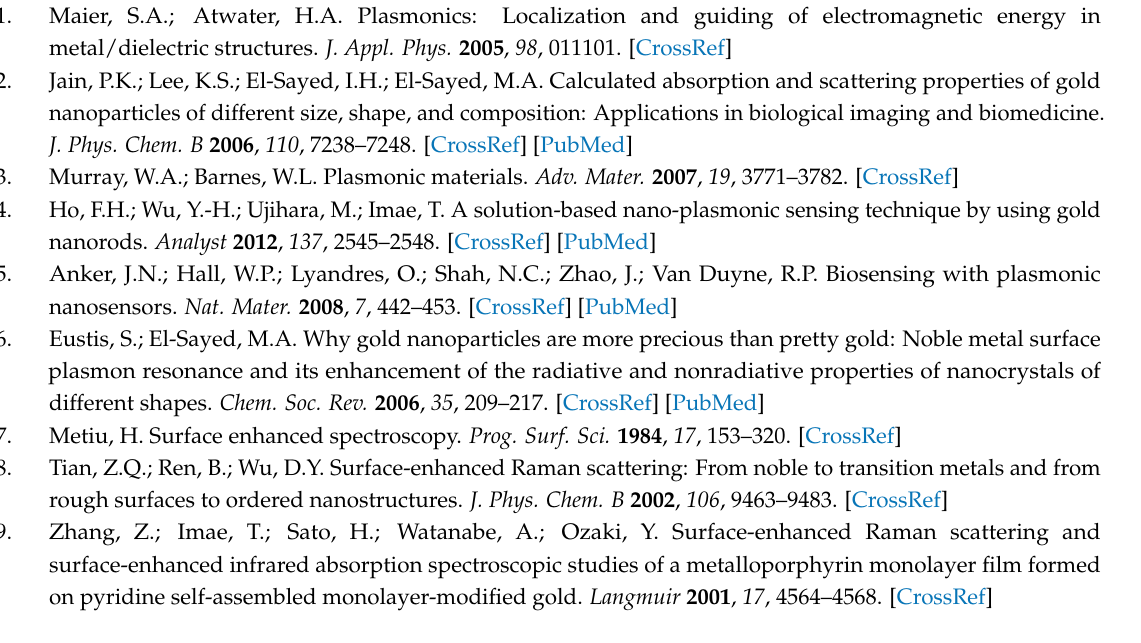
Figure S1: Raman scattering of confeito-like AuNPs without R6G. Figure S2: Raman scattering of R6G at 50 µ M in the dispersions and on the films of (A) small confeito-like AuNPs and (B) large confeito-like AuNPs. Figure S3: An optical image of SERS substrate (small confeito-like AuNPs and R6G at 50 µ